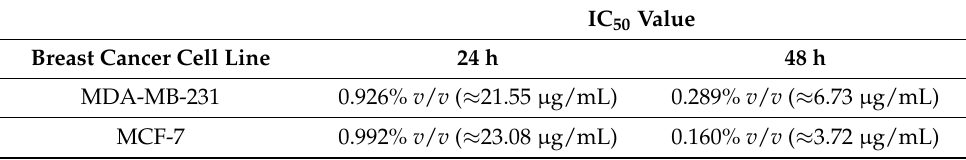
Figure 1. Antiproliferative effect of ScBEE on breast cancer cell lines and normal mesenchymal stem cells. A significant dose- and time-dependent decrease in the proliferation of ( A ) MDA-MB-231 and ( B ) MCF-7 cell lines was observed, with no cytotoxic effect on ( C ) normal mesenchymal stem cells (MSCs) when treated with high doses of ScBEE. Significant differences are reported; * indicates a p -value of 0.01 < p < 0.05, ** indicates a p -value of 0.001< p < 0.01 and *** indicates a p -value of 0.0001 < p < 0.001. Table 1. IC 50 of MDA-MB-231 and MCF-7 cells after 24 and 48 h incubation with